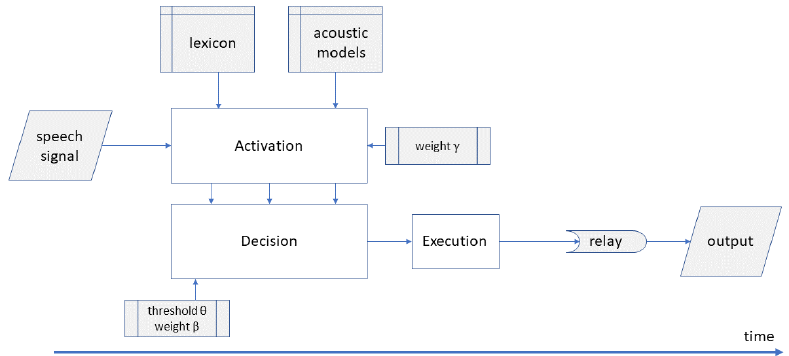
Figure 1. Overall architecture of the DIANA model. The acoustic signal is input for the activation component. During the unfolding of the input, the activation component computes activations and hypotheses which are input for the decision component. The output of DIANA is an overt decision (e.g., word identification or word evaluation) and corresponding reaction time. The two activation and decision components operate in parallel, while the decision and execution components operate